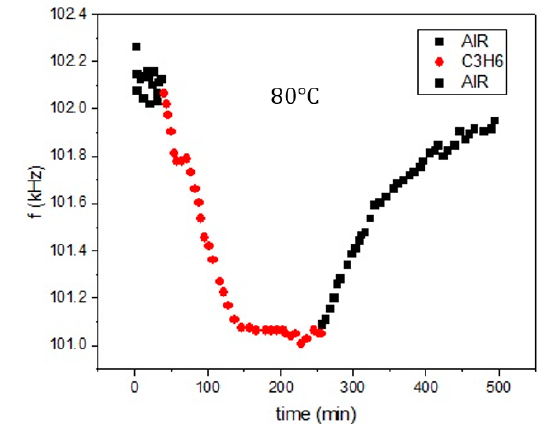
Figure 5. Data from PhD work [35], which corresponds to different propene concentrations on a Metglas/Linde Type A (LTA) sensor.